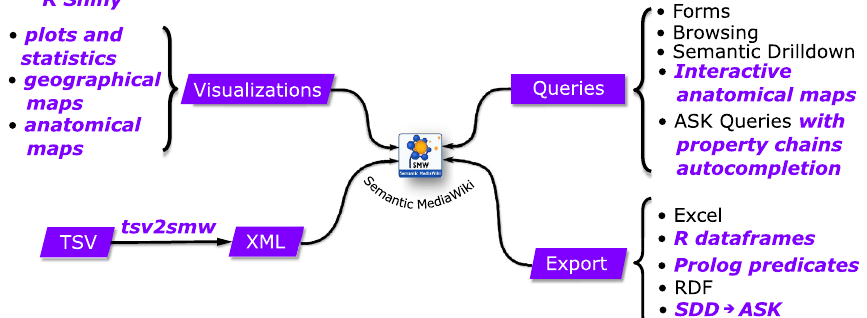
Figure 1. SMW aspects that have been extended: several SMW aspects have been extended and they have been written in purple. Their parent groups have been represented by parallelograms when related to inputs, otherwise they have been represented by rectangles [Created with Inkscape 1.1.2 (b8e25be833, 2022-02-05) by the first author; https:// inksc ape.